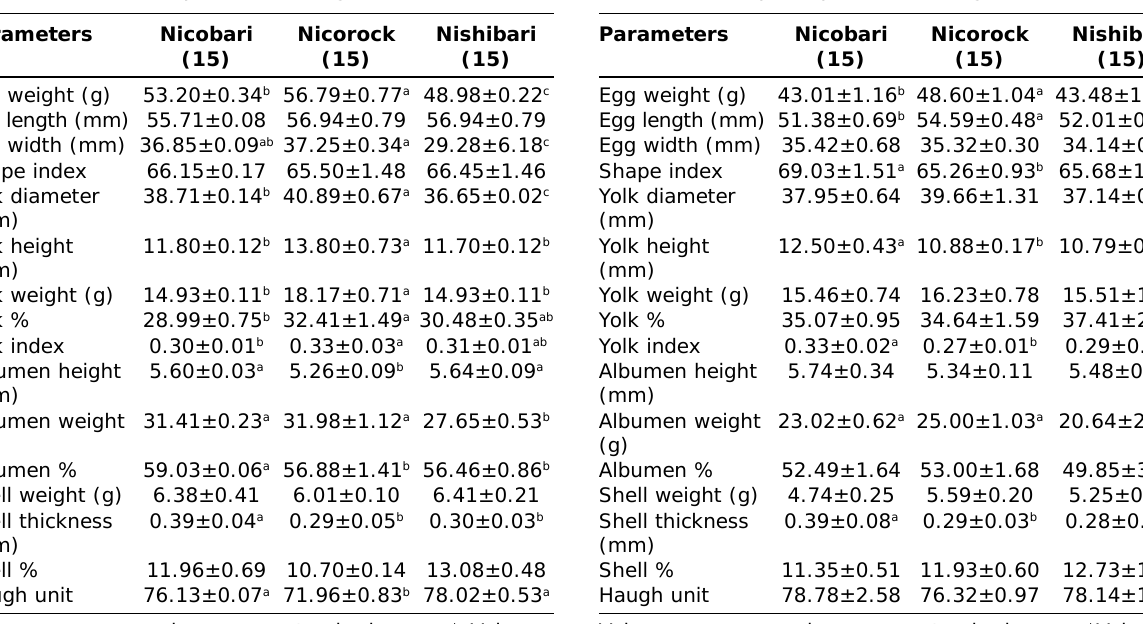
Table-3: Egg quality traits of Nicobari and Cross Nicobari fowl under backyard system of